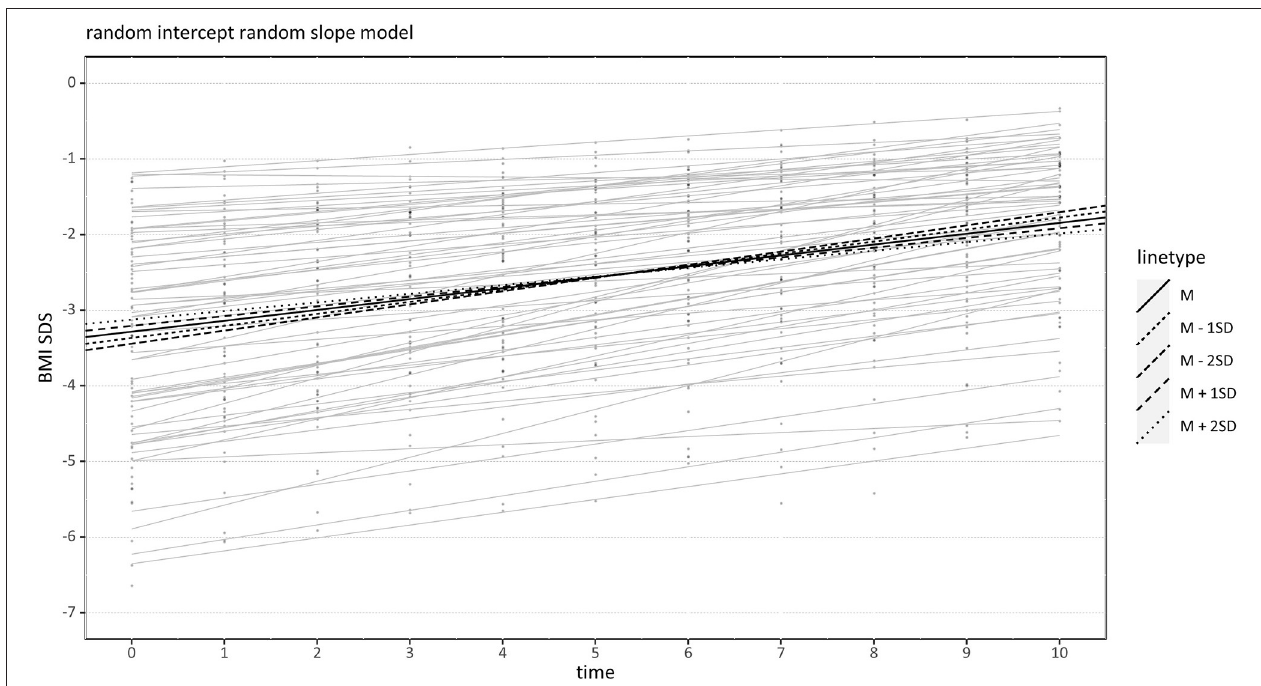
FIGURE 2 | Effect of Assessment of Identity Development in Adolescence (AIDA) on BMI-SDS Increase over Time. Black lines indicate conditional regression lines for very low ( M − 2 SD ), low ( M − 1 SD ), medium ( M ), high ( M + 1 SD ), and very high ( M + 2 SD ) AIDA scores. BMI-SDS, Body mass index standard deviation